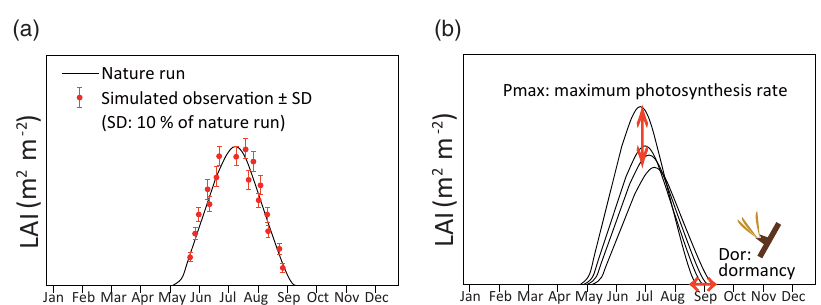
Figure 2. Schematic illustrations of the nature run, observations, and model parameter sensitivities. (a) Time series of LAI (m 2 m − 2 ) for the nature run (black), simulated observations (red dots), and their error standard deviations (SD, red error bars). (b) Time series of LAI with different Pmax and Dor values. The perturbed parameters (Pmax and Dor for tree and grass) cause differences between the particles.